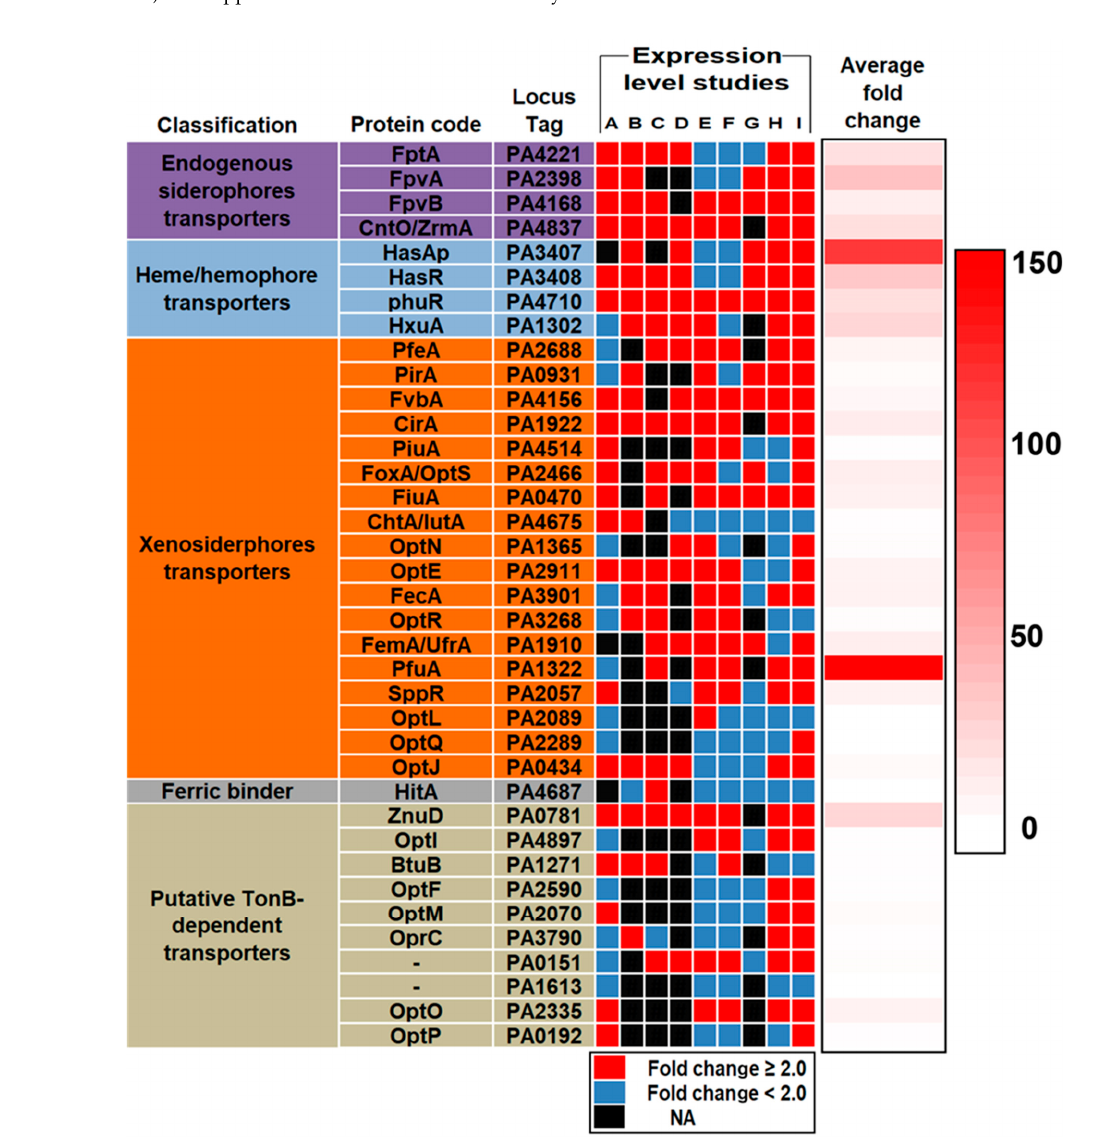
Figure 1. Heatmap showing the expression level studies and the average fold change for each IAP. White, light red, and dark red indicate low, moderate, and high expression levels, respectively . PiuA, ChtA, FiuA, PfeA, and HitA were the top five proteins in terms of average antigenicity scores from Antigenic and AntigenPRO tools (Suppl. File S2). HitA, HasAp, ZnuD, PirA, and CntO were the most soluble according to solubility scores obtained from the SolArt tool (Suppl. File S2).